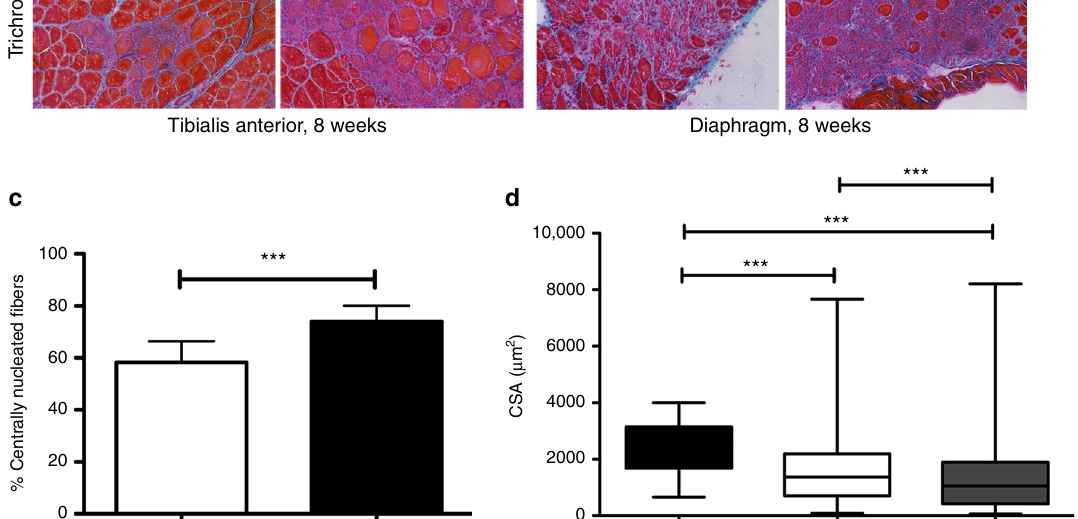
Fig. 5 N fi x overexpression in skeletal muscle exacerbates the dystrophic phenotype. a Hematoxylin and eosin (H&E) and Milligan ’ s trichrome staining of tibialis anterior (left) and diaphragm (right) muscles at 5 weeks of age; N = 4 Sgca null and 9 Sgca null: Mlc1f-N fi x2 mice. Scale bar 100 μ m. b Hematoxylin and eosin (H&E) and Milligan ’ s trichrome staining of tibialis anterior (left) and diaphragm (right) muscles at 8 weeks of age; N = 6 Sgca null and 30 Sgca null: Mlc1f-N fi x2 mice. Scale bar 100 μ m. c Percentage of centrally nucleated myo fi bers in tibialis anterior muscles at 8 weeks of age; N = 11 Sgca null and 18